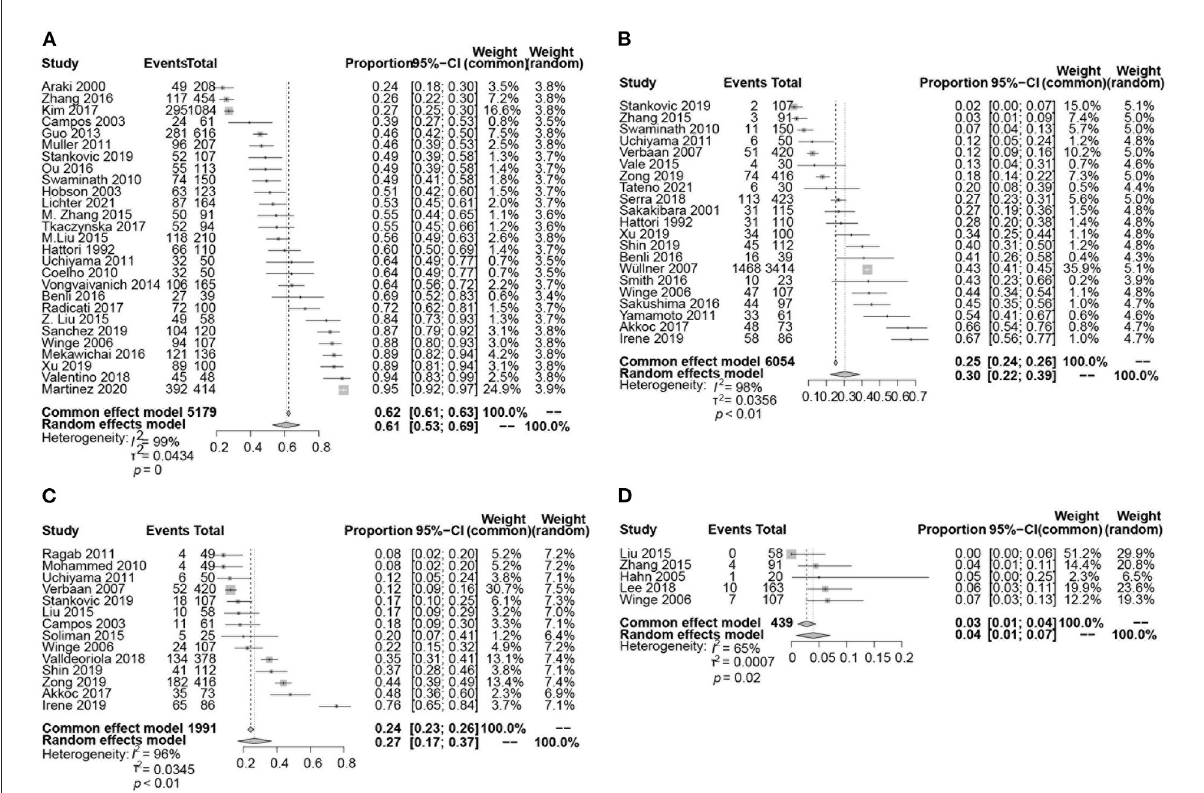
FIGURE2 Forest plot showing the prevalence of LUTS (A) , urinary incontinence (B) , urinary retention (C) , and post-void residual (PVR) volume ≥ 100ml (D) in PD patients.